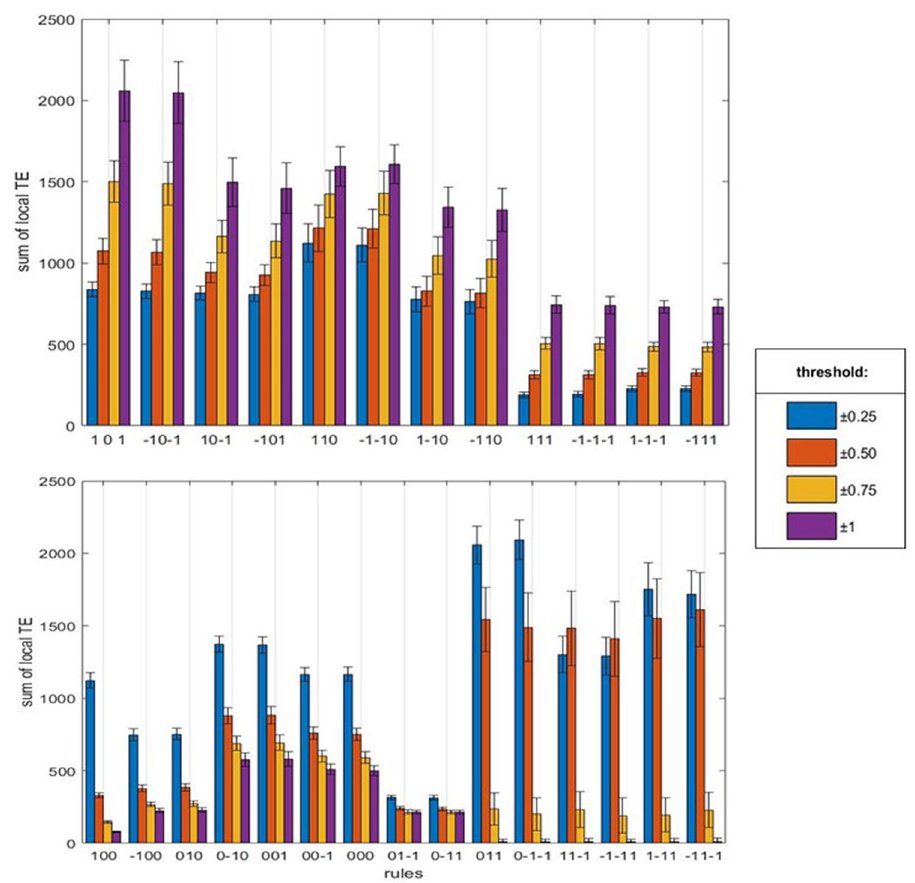
Figure 4. Sums of local TE in the interaction rules at increasing signal thresholds. The sums include the individual values of the subjects in the database (see the Methods). Top panel: rules with an increasing trend at increasing thresholds. Bottom panel: rules with mixed trends at increasing thresholds. Right panel: threshold values in the filtering procedure and colours